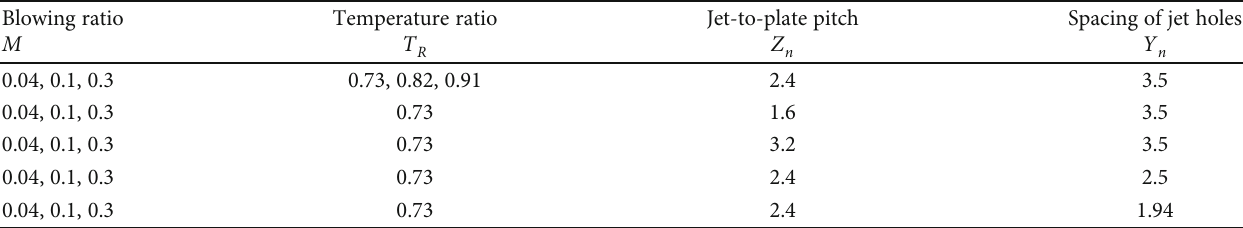
Table 1: Operating Conditions for PIV Experiments.